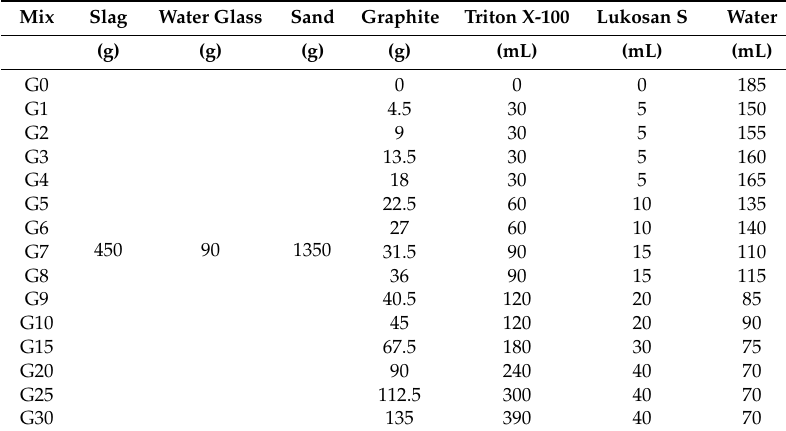
Table 2. Composition of the